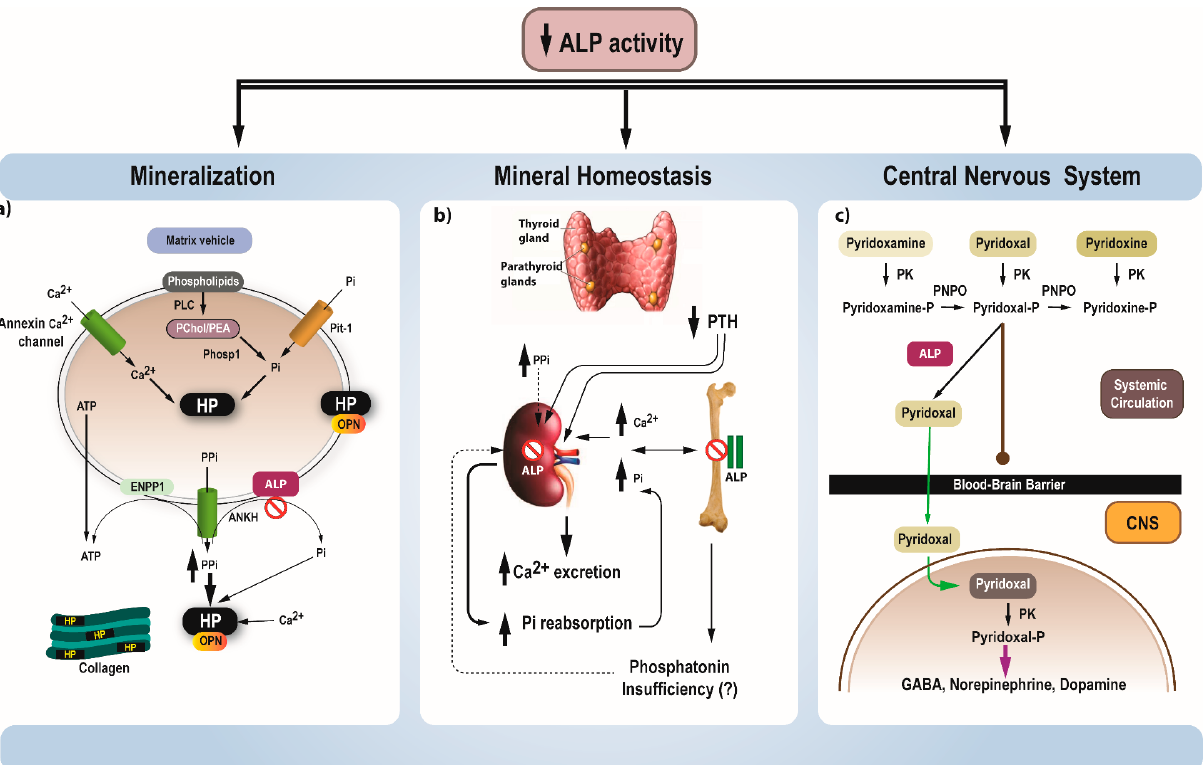
Figure 1. ( a ) Primary mineralization is initiated in the MV, which are buds of the osteoblast membrane. Pi produced within the MV by the action of PHOSPHO-1 on PChol and PEA derived from membrane phospholipids by the action of PLC and also transported intravesicularly by Pit-1, combines with calcium and forms hydroxyapatite crystals (Phase 1). Crystal growth results in the rupture of MV, then proceeds outside the MV, within the extracellular matrix and propagates on collagen fibrils (Phase 2). PPi, transported extravesicularly by ANKH and produced locally by the action of ENPP1 on ATP, is a strong inhibitor of mineralization. On the contrary TNAP promotes mineralization by hydrolyzing PPi, and by providing Pi. In HPP, phase 1 proceeds normally; however, elevated PPi levels due to deficient TNAP activity inhibits the mineralization of the skeletal matrix. Moreover, phosphorylated OPN, another inhibitor of mineralization, is also elevated in mouse models of HPP. ( b ) In severe cases with HPP, the blocked entry of calcium and Pi in the skeleton results in elevated calcium and Pi, appropriately followed by reduction of PTH levels and subsequent hypercalciuria. In mild cases, elevated Pi levels are observed, due to increased renal phosphate reabsorption. Possible explanations include direct role of TNAP in renal phosphate reabsorption, competition with excess PPi for the same transport mechanism and inappropriately normal or reduced levels of phosphatonins. ( c ) Of the vitamin B6 vitamers, only PLP can act as a cofactor for enzymes in the CNS. However, PLP must be dephoshoshorylated to PL in order to enter the cells and the blood brain barrier. TNAP accomplishes the dephosphorylation of PLP to PL, so it can pass the blood brain barrier. Within the cells PL is rephosphorylated by pyridoxal kinase to PLP, which acts as cofactor for GABA synthesis. Abbreviations: ALP, alkaline phosphatase, ANKH, ankylosis protein homolog; ATP, adenosine triphosphate; Ca, calcium; CNS, central nervous system; ENNPP1, ectonucleotide pyrophosphatase/phosphodiesterase; GABA, gamma-aminobutyric acid; HP, hydroxyapatite; HPP, hypophosphatasia; MV, matrix vesicles; OPN, osteopontin; PChol, phosphocholine; PEA, phoshoethanolamine; PK, pyridoxal kinase; PLC, phospholipase C; PNPO, pyridoxamine 5 (cid:48) -phosphate; Phosp-1, phosphate phosphatase 1; oxidase; Pi, Inorganic phosphate; Pit-1, phosphate transporter -1; PPi, pyrophosphate; PTH, parathyroid hormone; TNAP, tissue non-specific alkaline